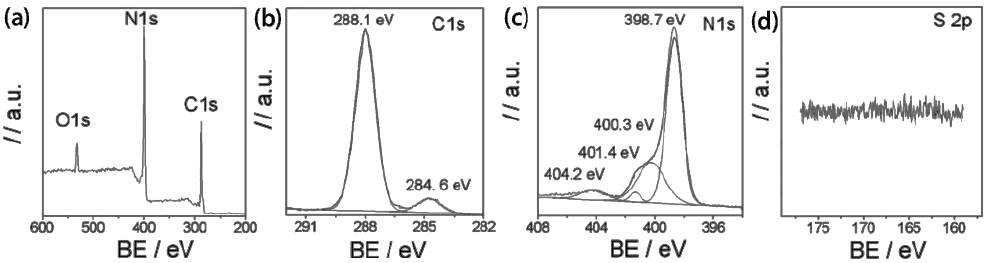
Figure 2. ( a ) XPS survey spectrum and the corresponding high-resolution spectra of ( b ) C ls, ( c ) N 1s and ( d ) S 2p obtained from the CN-T 500 sample. Used with permission from [73]. Copyright 2012 Royal Society of Chemistry.